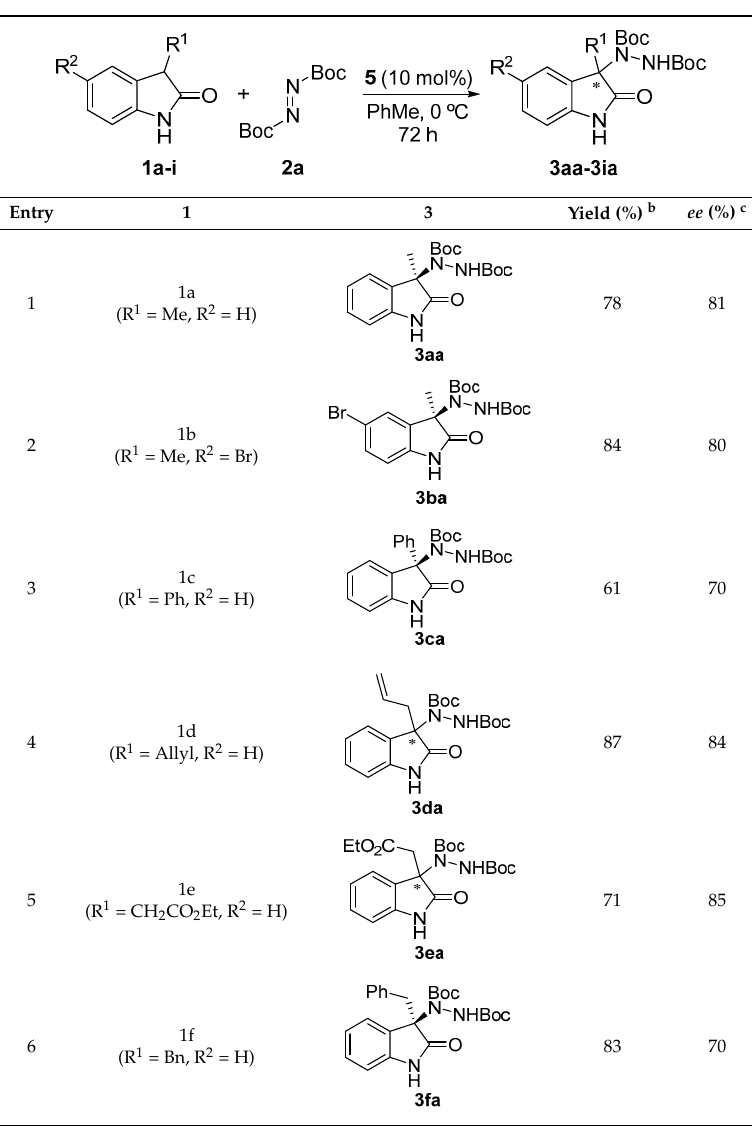
Table 2. Reaction scope a .